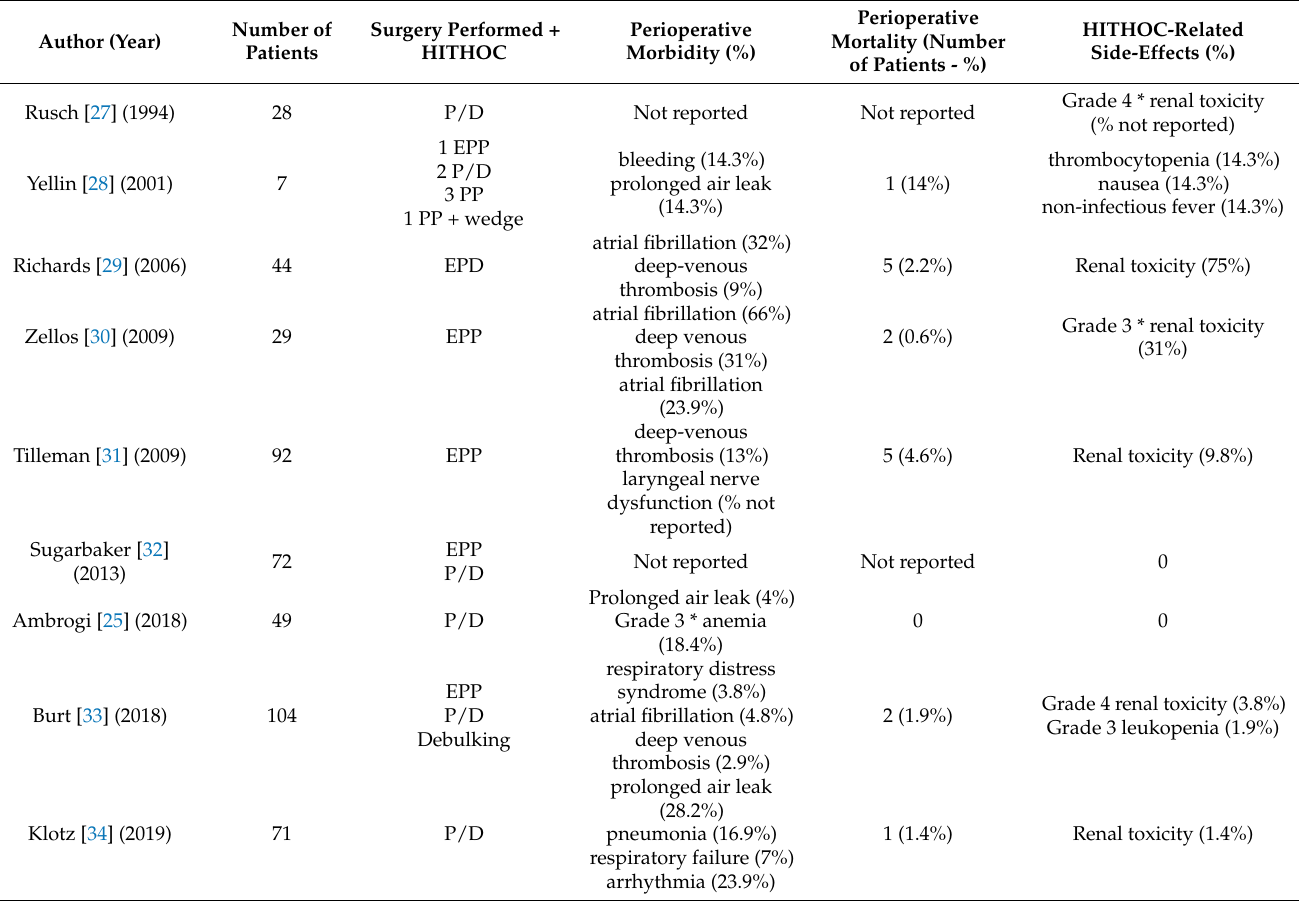
Table 3. Surgical procedures performed and perioperative outcomes. EPP= extrapleural pneumonectomy; P/D = pleurec- tomy/decortications; PP = partial pleurectomy; EPD = extended pleurectomy/decortication. * Common Terminology Criteria for Adverse Events (CTCAE)